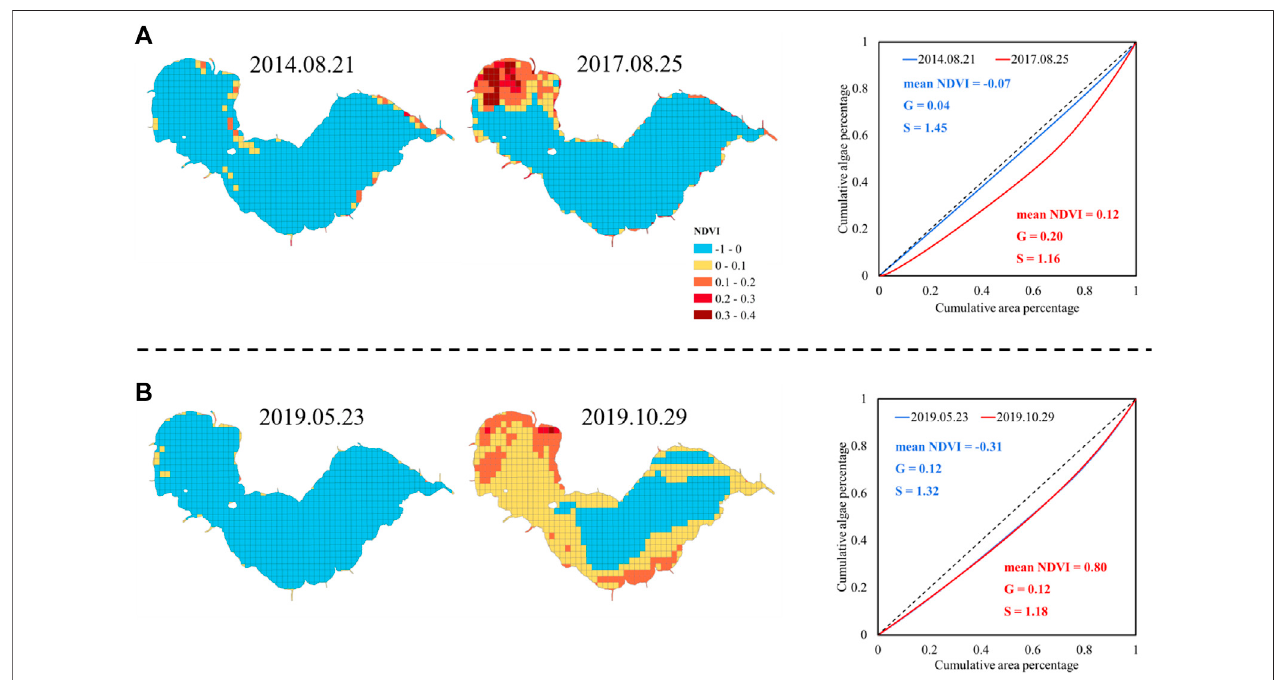
FIGURE 10 | Examples of algae distribution with (A) maximum and minimum G, and (B) maximum and minimum mean NDVI.